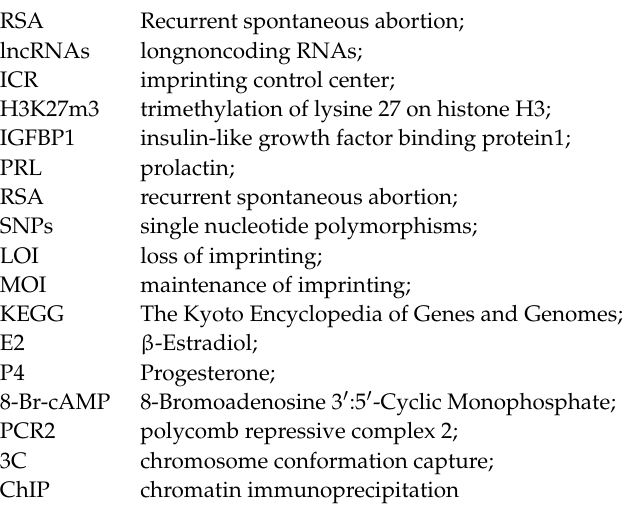
Table S1. Oligonucleotide primers used for PCR; Table S2. KEGG pathways that are associated with decidualization; Table S3. Top 11 associated lncRNAs of decidual tissues by RNA sequencing from 3 RSA patients (Log2FoldChange > 7); Table S4. Basal characteristics of controls and RSA patients; Table S5. Genotype and allelic expression of IGF2 and H19